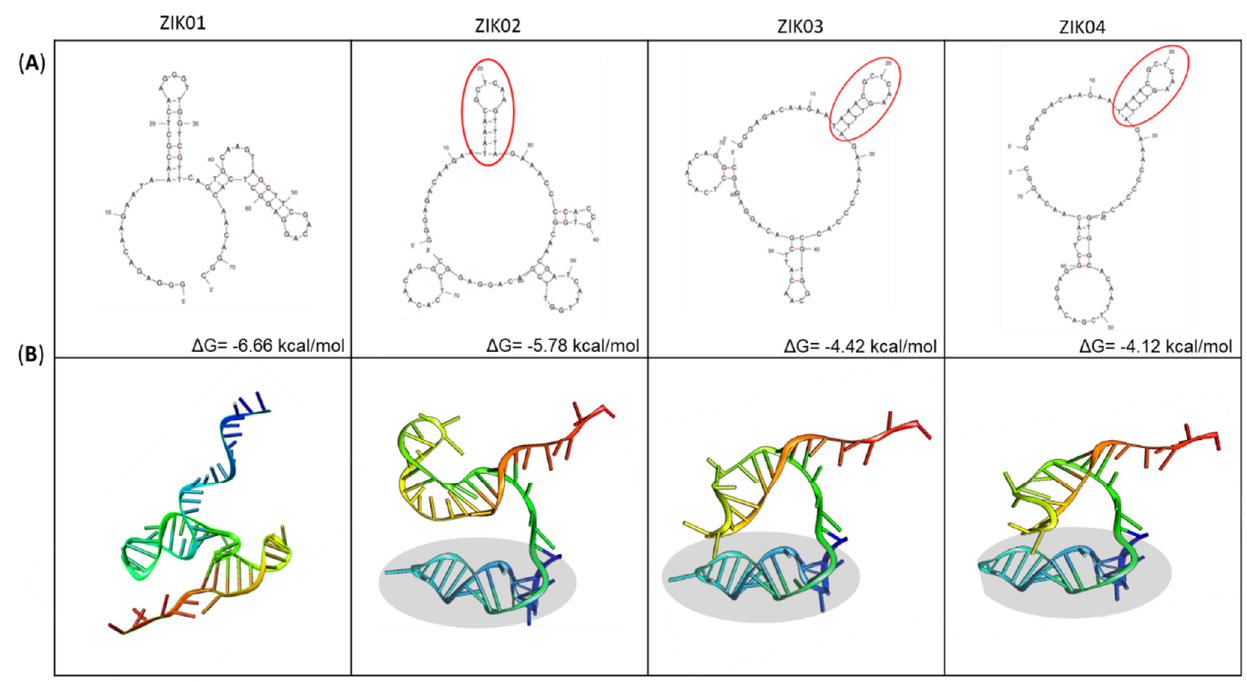
Figure 7. Prediction of secondary and tertiary structures of the four selected aptamers for Zika virus. ( A ) Secondary structure of the aptamers by Mfold web server. Parameters: linear DNA; folding temperature = 25 ◦ C; [Na+] = 0.1; [Mg++] = 0.01; unit = M; ∆ G = free energy; the circled areas show the same hairpins structures in 3 aptamers. ( B ) Computational prediction of the 3D structures of the aptamers using Chimera program. The highlighted areas indicate the same tertiary structure in three aptamers.